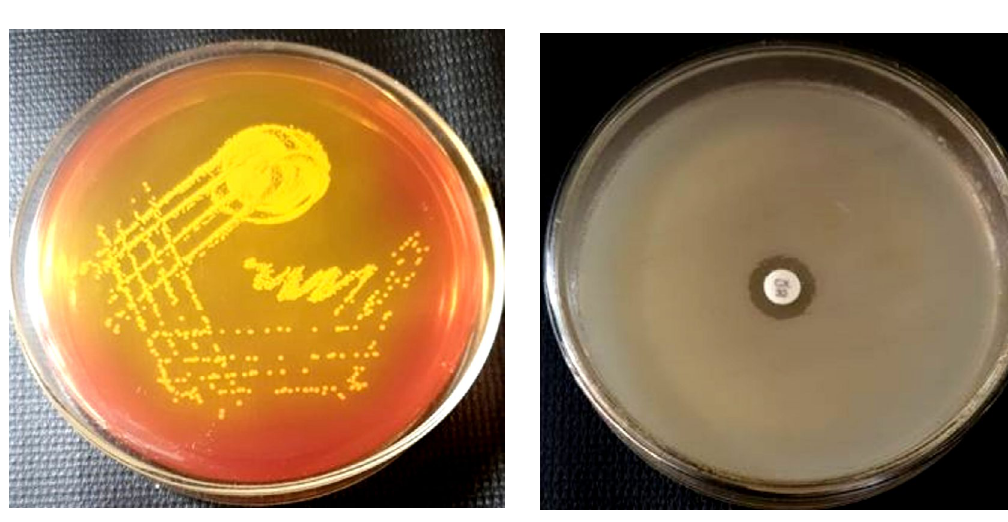
Fig. 2. Yellow coloured colonies of MRSA on Mannitol Fig. 3. Cefoxitin resistance displayed by MRSA Table 4. Gender distribution among the MRSA carriers